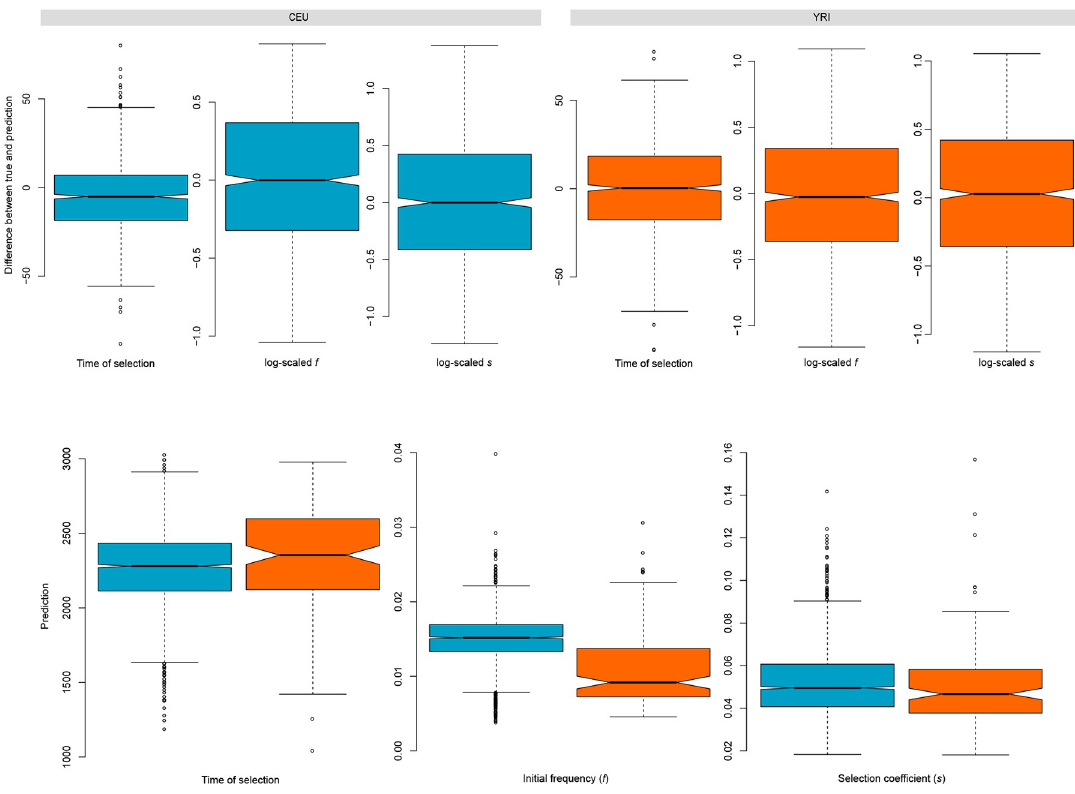
Fig 7. SURFDAWave predictors’ performance on simulated data and prediction results on empirical data. (Top row) Difference between unstandardized selection parameters with SURFDAWave for the CEU and YRI demographic models. (Left box plot) Difference in prediction and truth of log scaled time at which mutation became beneficial (measured in generations before present). (Middle box plot) Difference in prediction and truth of log scaled frequency reached by mutation prior to it becoming beneficial ( f ). (Right box plot) Difference in prediction and truth of log scaled selection coefficient ( s ). (Bottom row) Predicted distribution of selection parameters for all genes in YRI and CEU with probability of being classified as sweep greater than 0.7. (Left) Distribution of predicted time of selection (measured in generations before present). (Middle) Distribution of predicted frequency reached by mutation before becoming beneficial (initial frequency ( f )). (Right) Distribution of predicted selection coefficient ( s ).